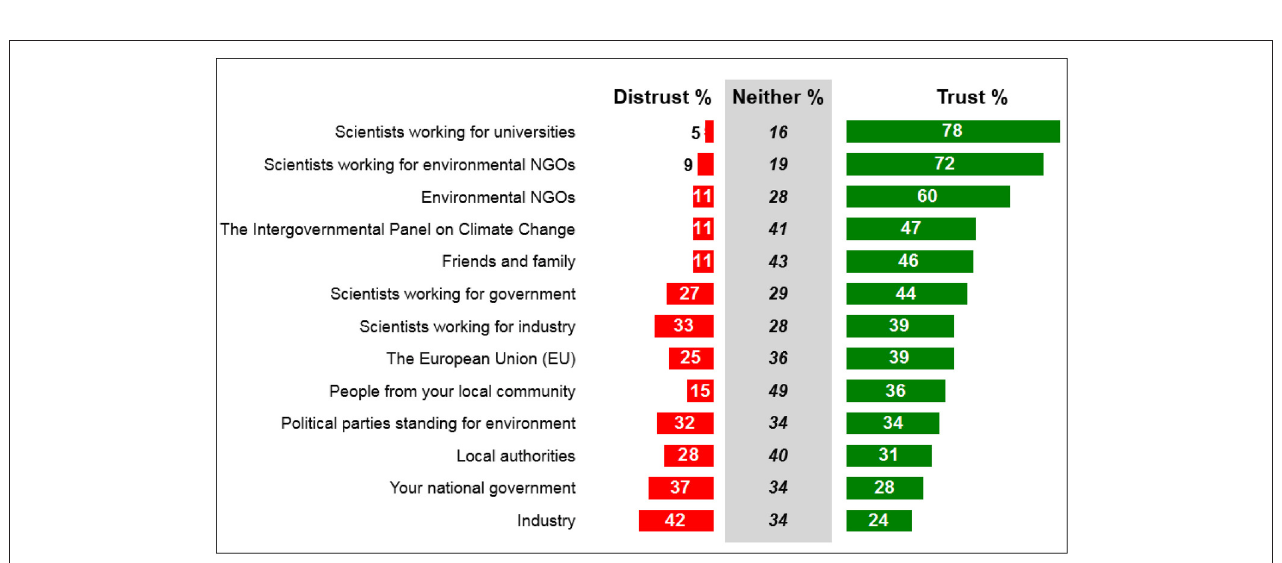
FIGURE 9 | Results from multiple choice questions “To what extent, if at all, do you trust* each of the following individuals or organizations when providing information about climate change impacts on the coastline or the sea?” [Sample = all 10 countries combined; N = 10,106 respondents]. * “Trust” = respondents answering 4 or 5 on a five-point scale, where 5 = trust a lot and 1 = distrust a lot. “Neither” = respondents answering the mid-point (3) on the same five-point